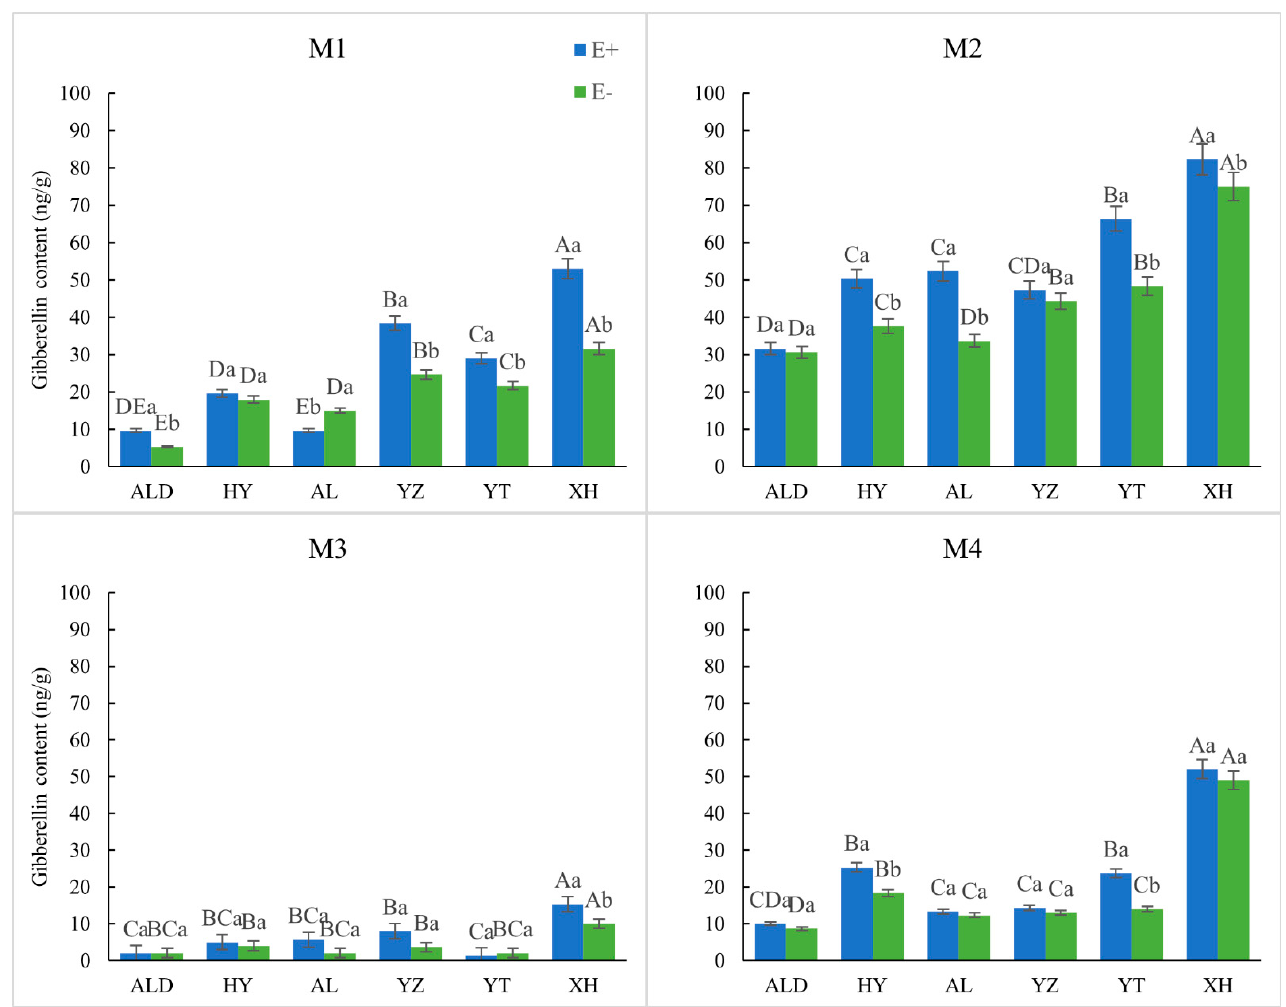
Figure 3. Relative gibberellin content of infected (E+) and non-infected (E − ) Achnatherum inebrians from different treatments on an altitude (origin) gradient. The different capital letters indicate the mean significant difference ( p < 0.05) in endophyte status (E+ or E − ) in seed germination under different origin. The different lowercase letters indicate the mean significant difference ( p < 0.05) in the pair-wise comparisons of endophyte status (E+ and E − ) in seed germination in the same origin.